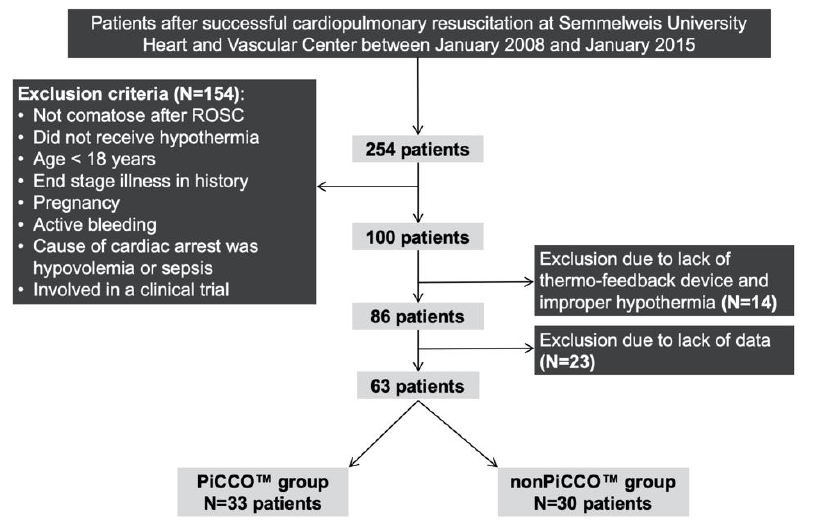
Figure 1. The selection of study population and eligibility of patients. A total of 254 patients after successful cardiopulmonary resuscitation were screened, and 63 were included into the study based on the inclusion and exclusion criteria. N: number of patients; PiCCO™: pulse index contour cardiac